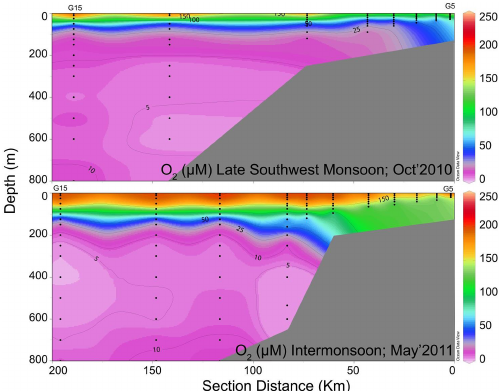
Figure 2. Cross-margin plots (to 800m) of dissolved oxygen con- centration (µM) during the late monsoon season (October 2010, up- per panel) and intermonsoon season (May 2011, lower